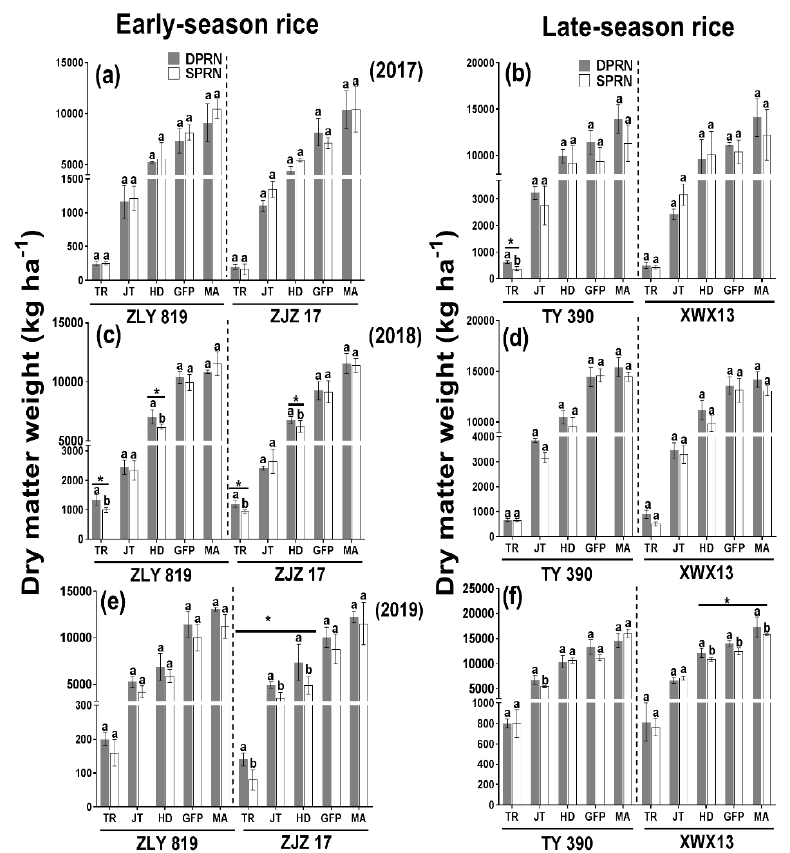
Figure 5. Dry matter weight of double-cropped rice under different treatments from 2017 to 2019. Data points represent treatment means ( n = 3), and different letters indicate significant differences (* p < 0.05). DPRN represents dense planting with a reduced nitrogen rate; SPHN represents sparse planting with a high nitrogen rate. ZLY 819 (hybrid rice) and ZJZ17 (conventional rice) belong to early-season rice cultivars; TY 390 (hybrid rice) and XWX 13 (conventional rice) belong to late-season rice cultivars. TR represents the tillering stage; JT represents the jointing stage; HD represents the heading stage; GFP represents the grain-filling period; MA represents the maturity stage; ( a ) represents early − season rice in 2017; ( b ) represents late − season rice in 2017; ( c ) represents early − season rice in 2018; ( d ) represents late − season rice in 2018; ( e ) represents early − season rice in 2019; ( f ) represents late − season rice in 2019. Table 1. The effective spike, grains per spike, seed setting rate (%) 1000 grain weight, and the grain yield of double-cropped rice under different treatments from 2017 to 2019.